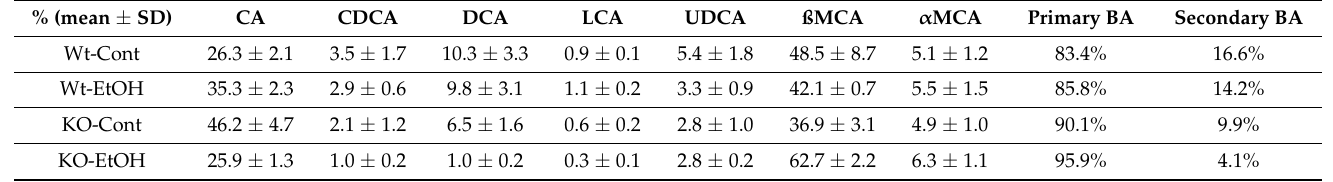
Table 1. Percentage of total bile acid pool in mice